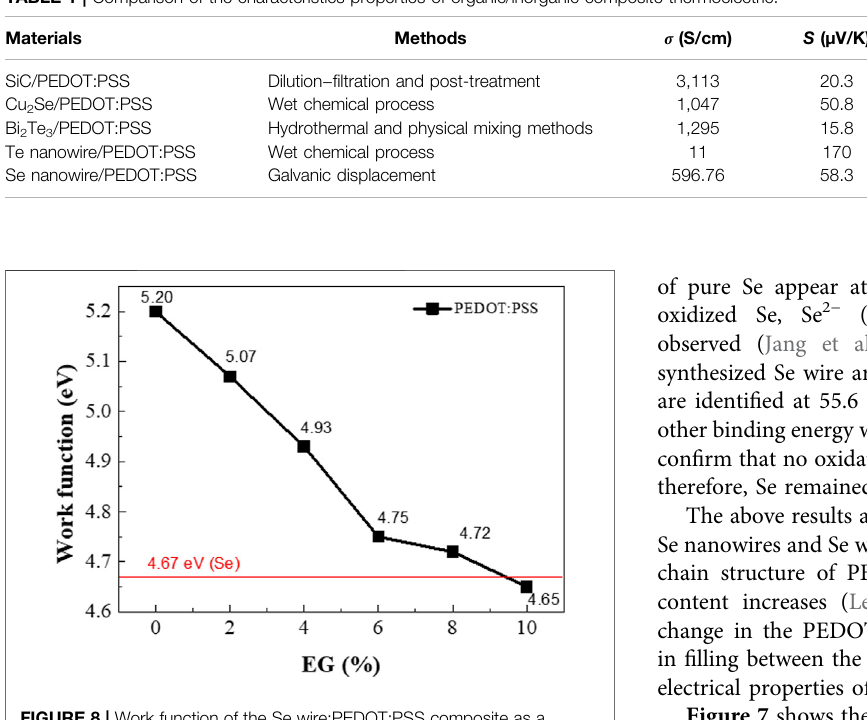
Frontiers in Chemistry |